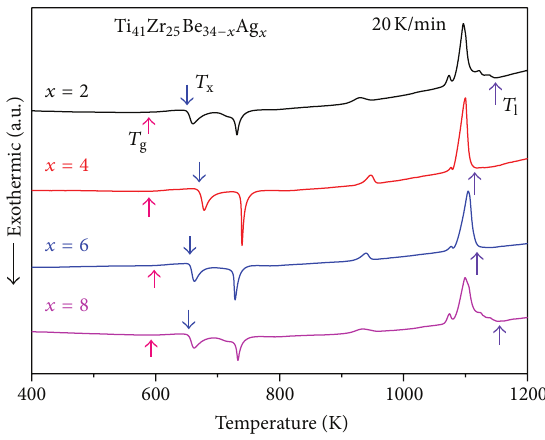
Figure 1: XRD patterns for the Ti 41 Zr 25 Be 34− glassy alloy system with their critical diameters.